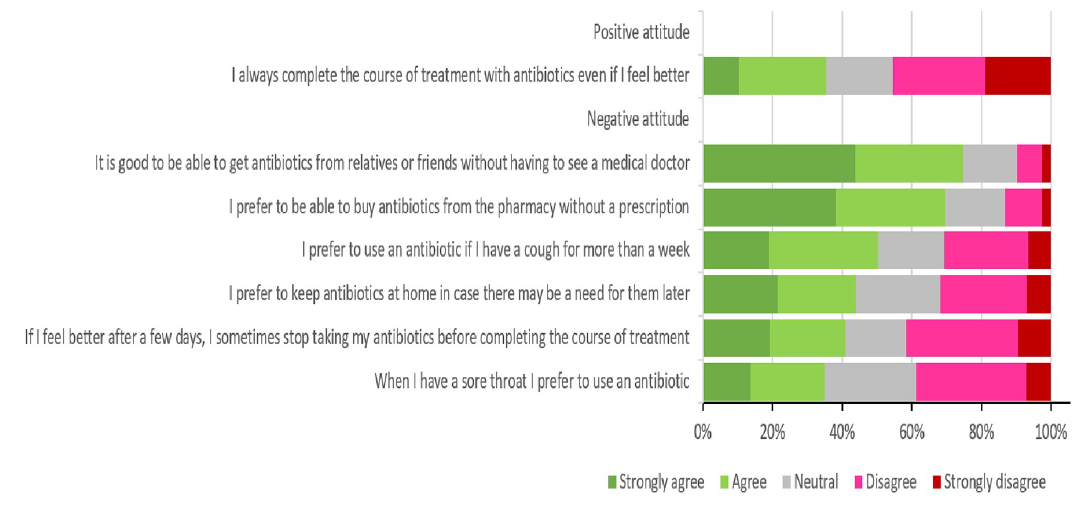
Fig 3. Respondents’ attitude towards antibiotic